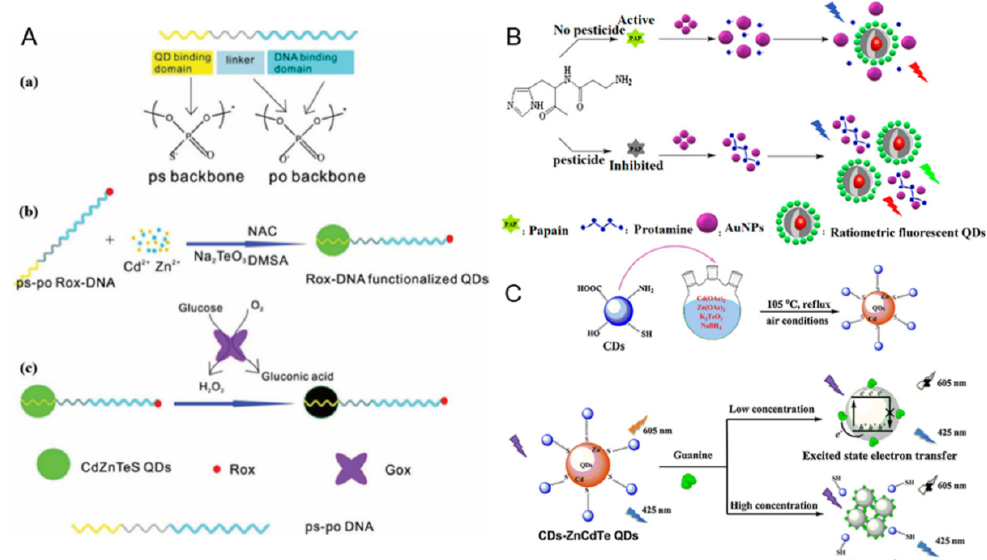
Figure 2. ( A ) Schematic description of ( a ) the structure of ps-po DNA (ps backbone: phosphorothioate linkage, which can bind to QDs due to their high affinity to cadmium; po backbone: phosphate linkage, which is the basic component of DNA.), ( b ) preparation of Rox-DNA functionalized CdZnTeS QDs, and ( c ) H 2 O 2 detection based on Rox-DNA functionalized CdZnTeS QDs. Reproduced from [42], with permission from the American Chemical Society, 2017. ( B ) Representation of fluorescence detection of CHL through IFE of gold nanoparticles on RF-QDs. Reproduced from [36], with permission from the American Chemical Society, 2020. ( C ) Proposed mechanism of fluorescence sensing guanine by CDs-ZnCdTe QDs. Reproduced from [43], with permission from Elsevier, 2018.